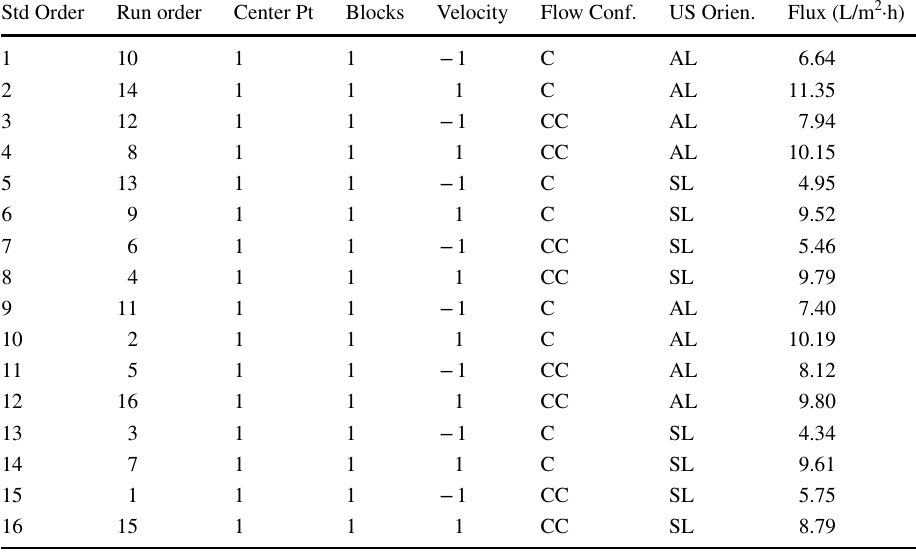
Table 7 Minitab output for the model coded coefficients for MgCl 2